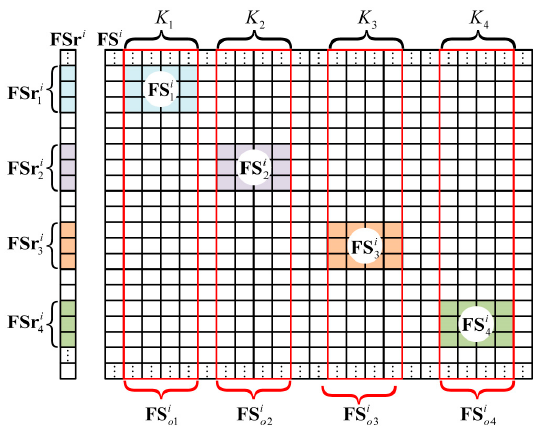
Figure 4. Extraction of the range profile vector, and conformation of the range profile reference signal matrix.